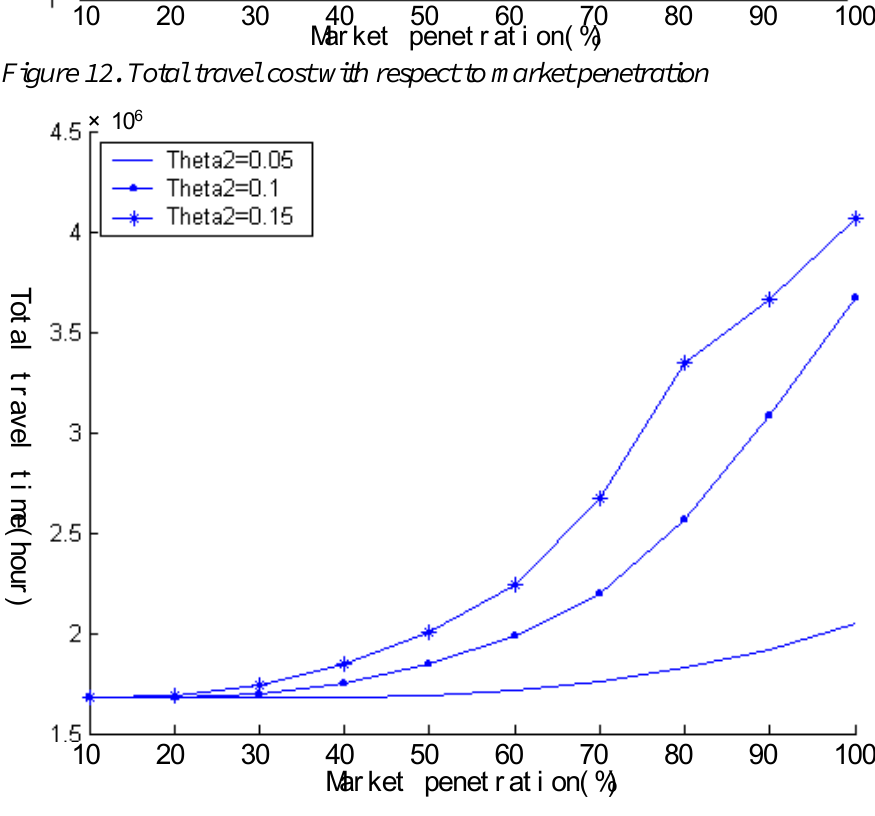
Figure 13. Total travel time with respect to market